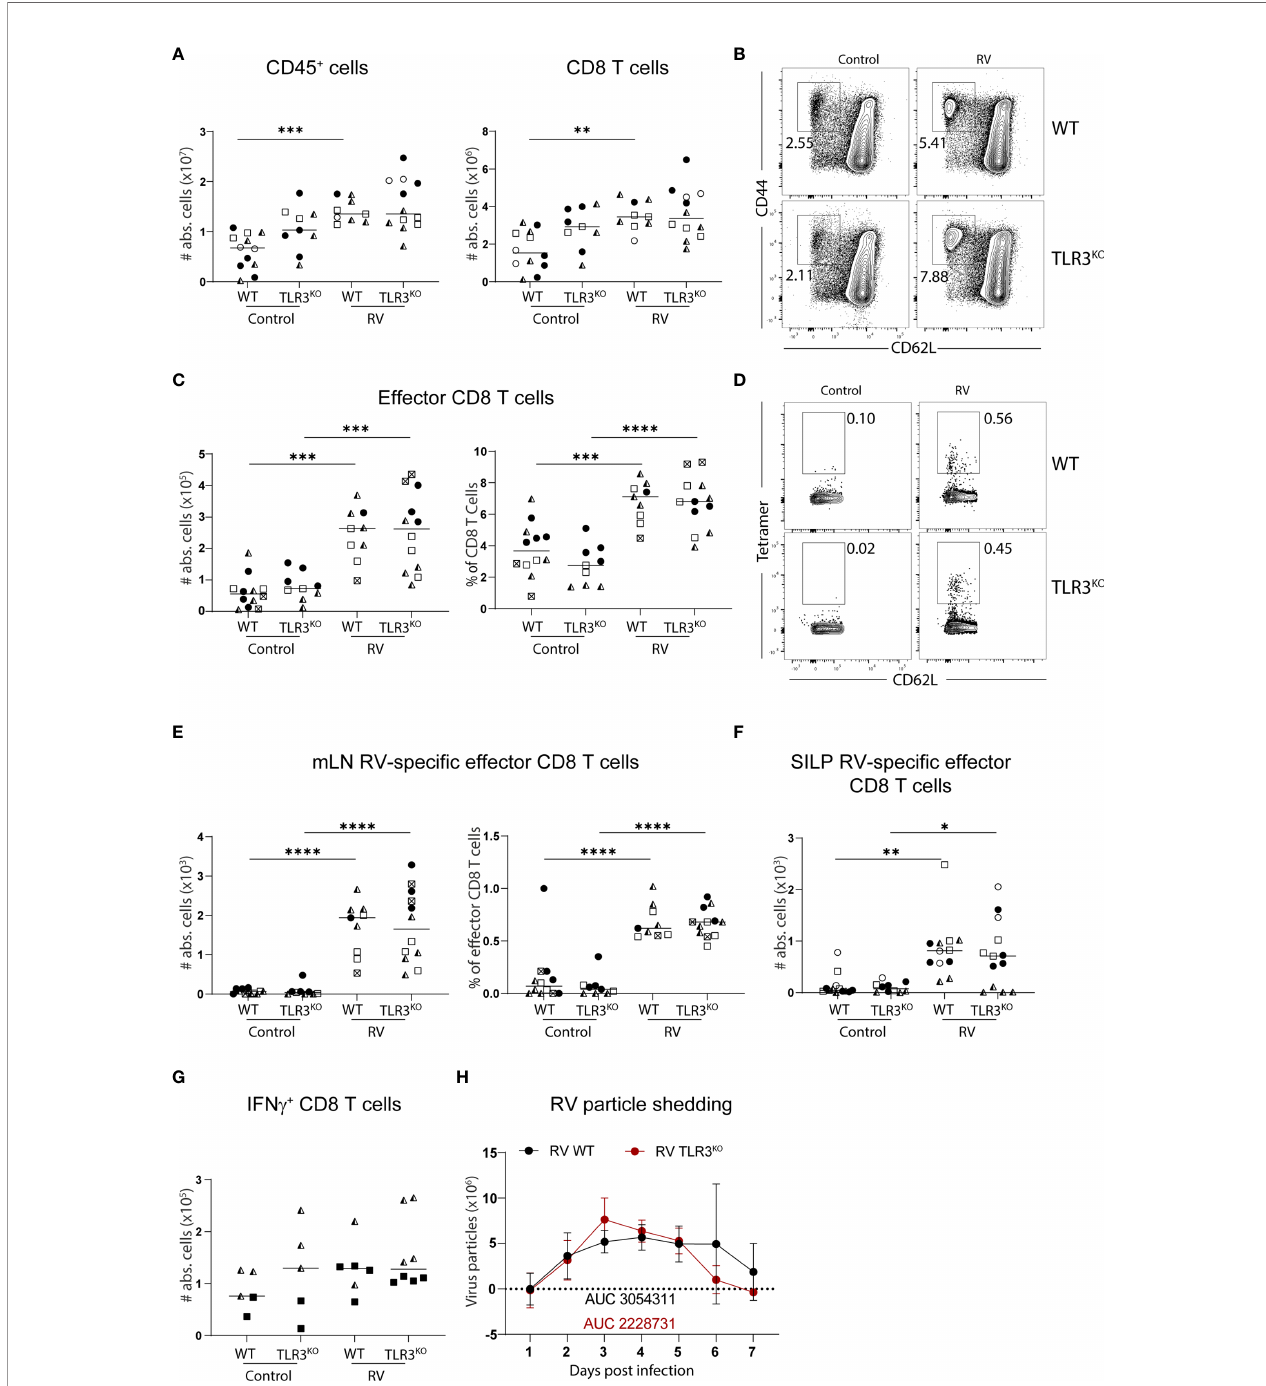
FIGURE 1 | Lack of TLR3 does not affect the RV-speci fi c CD8 T cell response. WT and TLR3 KO mice were infected with RV. (A – E , G) MLN cells and (F) SILP cells isolated from uninfected control and RV infected WT and TLR3 KO mice seven days post oral infection. (A) Total number of CD45 + cells and CD8 T cells (CD45 + CD3 + CD4 - CD8 a + ). (B) Representative FACS plot of effector CD8 T cells (CD62L - CD44 + ) pre-gated on CD45 + CD3 + CD4 - CD8 a + cells. (C) Absolute cell numbers and frequency of effector CD8 T cells (CD62L - CD44 + ). (D) Representative FACS plot of RV-speci fi c effector CD8 T cells (CD44 + CD62L - Tet + ). (E) Absolute cell numbers and frequency of RV-speci fi c effector CD8 T cells. (F) RV-speci fi c CD8 T cells (CD45 + CD3 + CD4 - CD8 a + CD44 + Tet + ). (G) MLN cells isolated seven days post infection and restimulated with PMA/Ionomycin. Absolute cell number and frequency of IFN g + CD8 T cells (CD45 + CD3 + CD4 - CD8 a + CD44 + IFN g + ) analysed by fl ow cytometry. (H) Level of RV shedding measured by ELISA on fecal samples collected at indicated time points (AUC, area under the curve). Each data point represents one mouse from a total of four different experiments (two for (G) , indicated by the different symbols. Ordinary one-way ANOVA with Tukey´s multiple comparison test was performed for statistical analysis. *p < 0.05, **p < 0.01, ***p < 0.001, ****p <